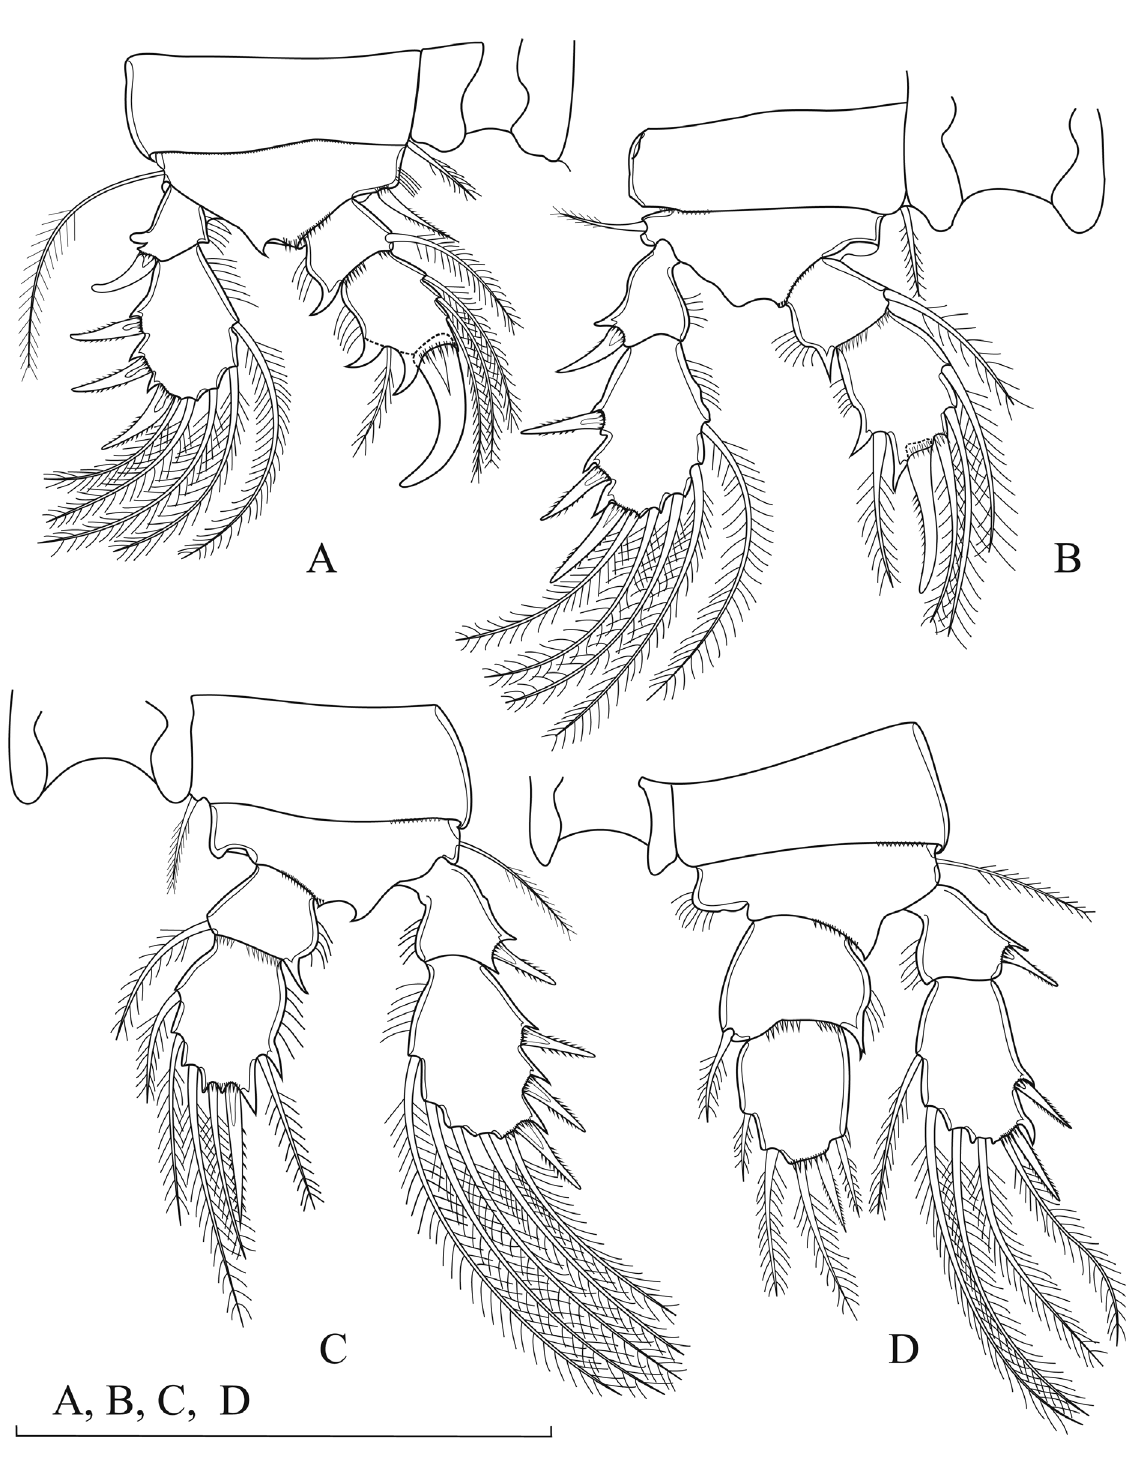
Fig. 3. Siamcyclops cavernicolus gen. et sp. nov., holotype, ♀. A . P1. B . P2. C . P3. D . P4. Scale bar: 100